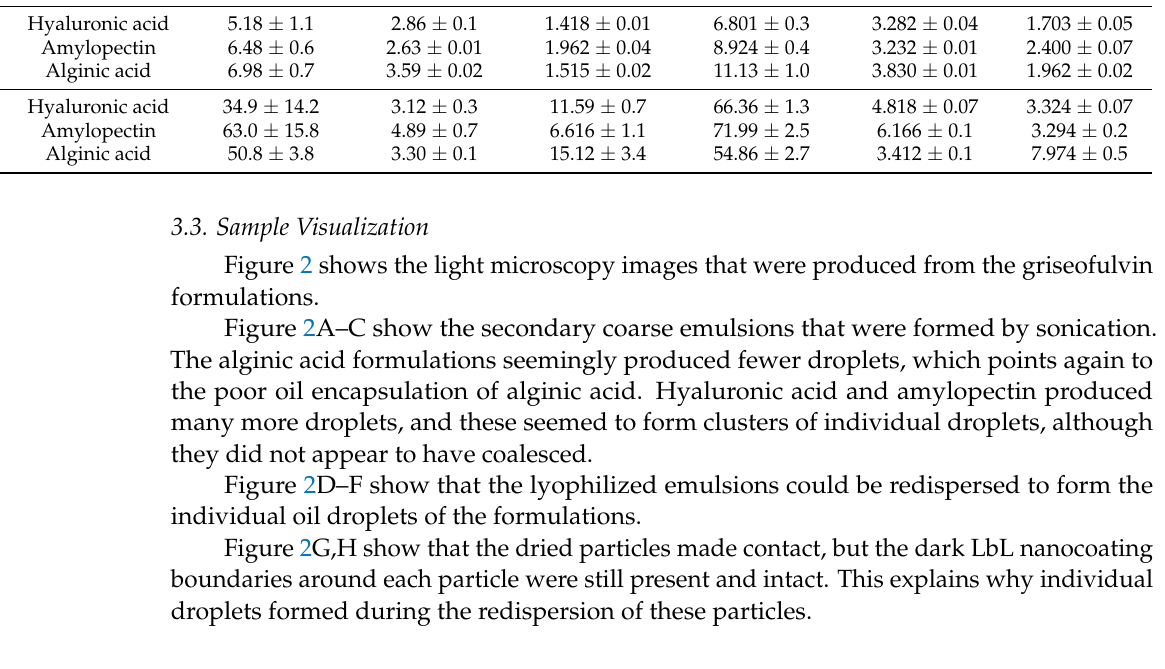
Table 3. Particle sizing of the griseofulvin formulations. Day